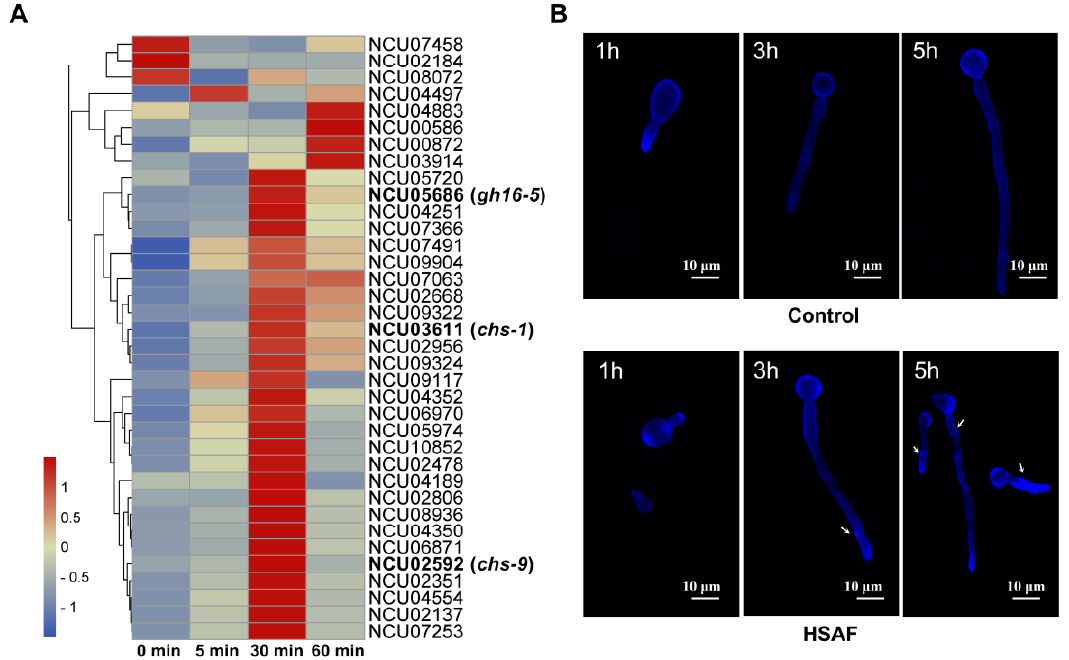
Figure 2. The effect of HSAF treatment on the formation and remodeling of cell wall. ( A ) The heat map of DEGs related to fungal-type cell wall organization. The heat map was constructed by R software pheatmap package with the original FPKM value of each gene; ( B ) Microscopic morphological characteristics and cell wall staining by CFW at different time of spore germination (1 h, 3 h, 5 h). The arrows indicate the regions with the thickened cell wall. Images show the results of one out of three replicates.